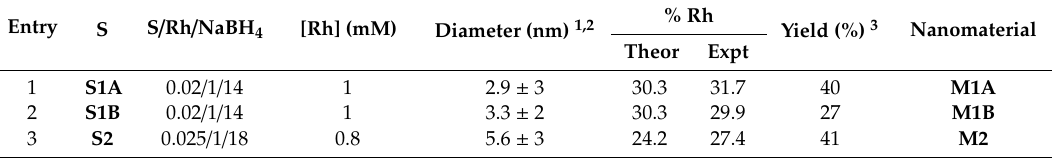
Table 1. Preparation of Rh NPs stabilized by S1A , S1B and S2 .